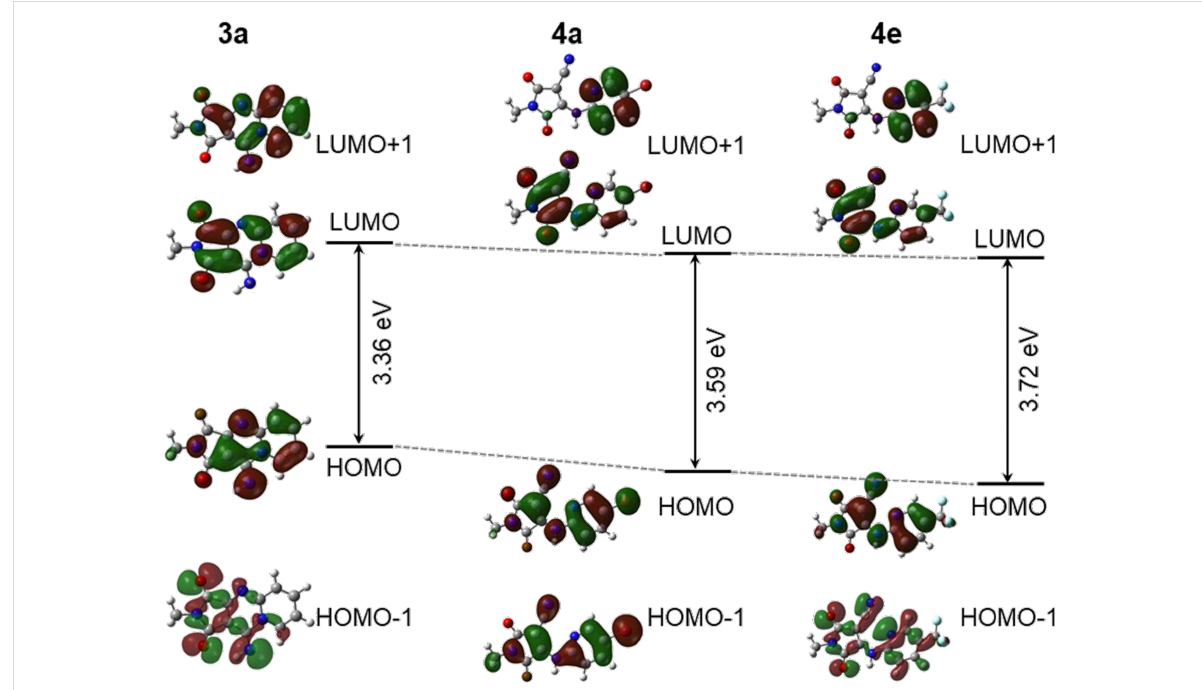
Figure 5: Frontier molecular orbitals and HOMO–LUMO energy gaps of compounds 3a , 4a , and 4e for ground-state calculated by using the B3LYP/6- 31G(d,p) level of theory in dichloromethane.